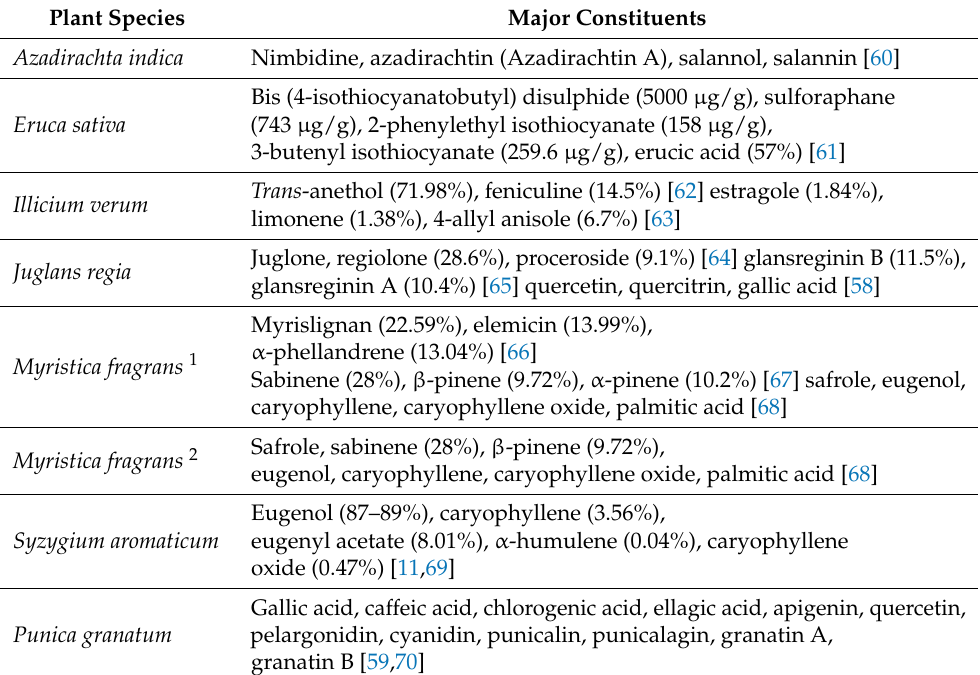
Table 5. Chemical composition of active plants according to